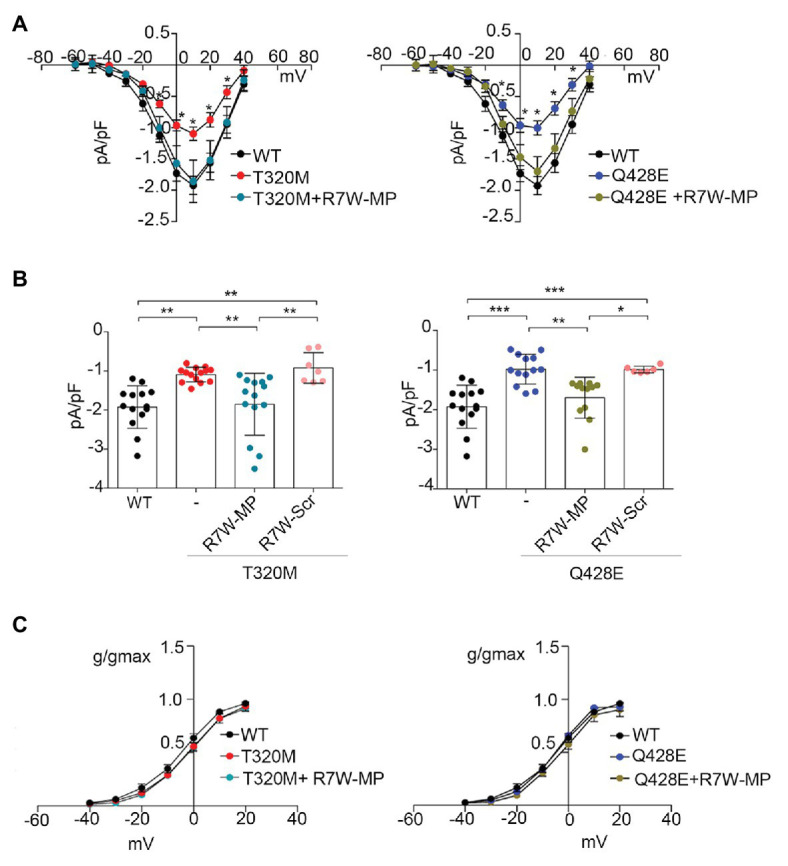
Treatment with R7W-MP corrects Ca2+ alterations due to Cavα1.2 mutations in a heterologous cell model. (A) Current-voltage (I-V) relationships recorded in HEK293 cells transiently co-transfected with Cavα1.2 WT (WT, n = 14), Cavα1.2 T320M (T320M, n = 14), or Cavα1.2 Q428E (Q428E, n = 13) and Cavβ2 at baseline and 24 h after treatment with 1.3 μM R7W-MP (T320M + R7W-MP, n = 14; Q428E + R7W-MP, n = 12). (B) Single dots and histograms (average) showing ICa measured at a test pulse of +10 mV for all the above-mentioned experimental conditions. *
p < 0.05, **
p < 0.01, ***
p < 0.001 (Kruskal-Wallis test). (C) Graphical representation of ICa activation-curves (g/gmax) for WT (V1/2 = −4.09 ± 1.81, slope = 8.29 ± 0.37), T320M (V1/2 = −1.90 ± 0.93, slope = 8.79 ± 0.60), and Q428E (V1/2 = −5.10 ± 0.92, slope = 7.64 ± 0.95). Kinetic curves did not change after R7W-MP treatment (V1/2 = −2.19 ± 1.18, slope = 8.21 ± 0.37; V1/2 = −3.69 ± 0.64, slope = 7.71 ± 0.31 for T320M + R7W-MP and Q428E + R7W-MP, respectively).